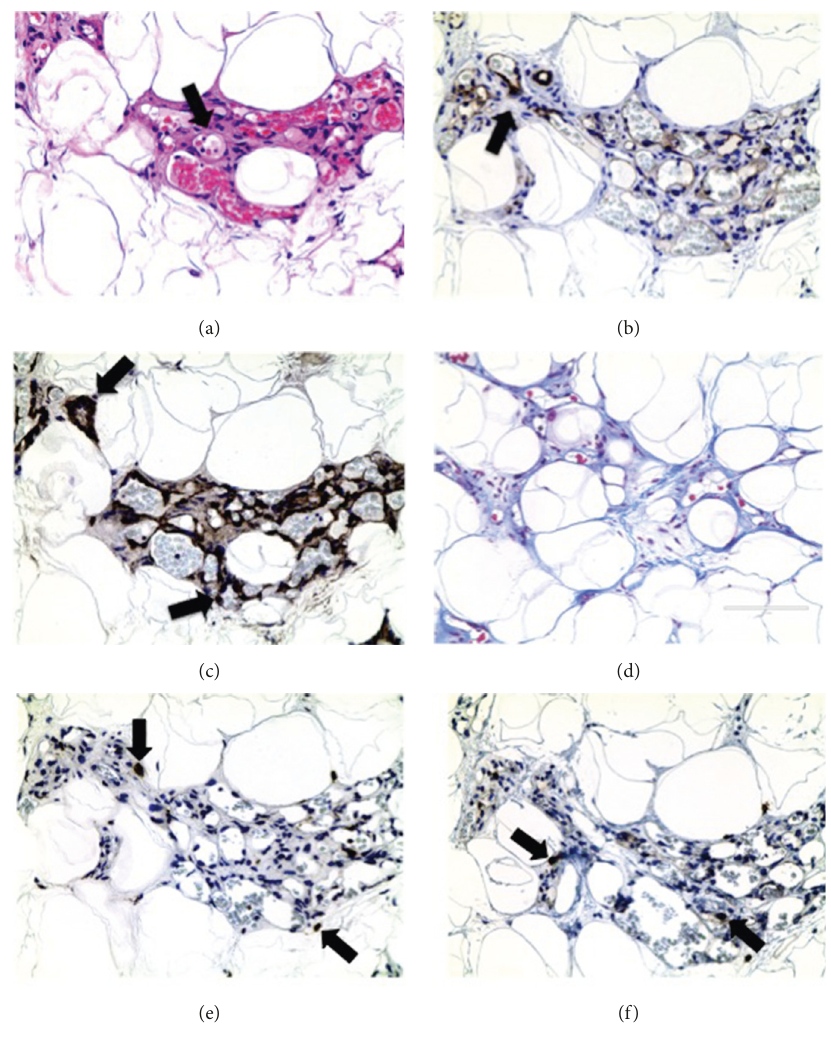
Figure 5: Angiogenesis in Non-Obese Lipedema leg fat. (a) H&E stain. Arrows indicate blood vessel lumens around adipocytes. (b, c) Immunohistochemistry of CD31 and SMA confirms the blood vessel origin of the tissue structures. (d) Trichrome stain demonstrating fibrosis in the areas of increased blood vessels. (e, f) Immunohistochemistry of CD68-labeled macrophages and CD117-labeled mast cells (arrows). Images captured at 40x objective lens (scale bar: 100 μ m).